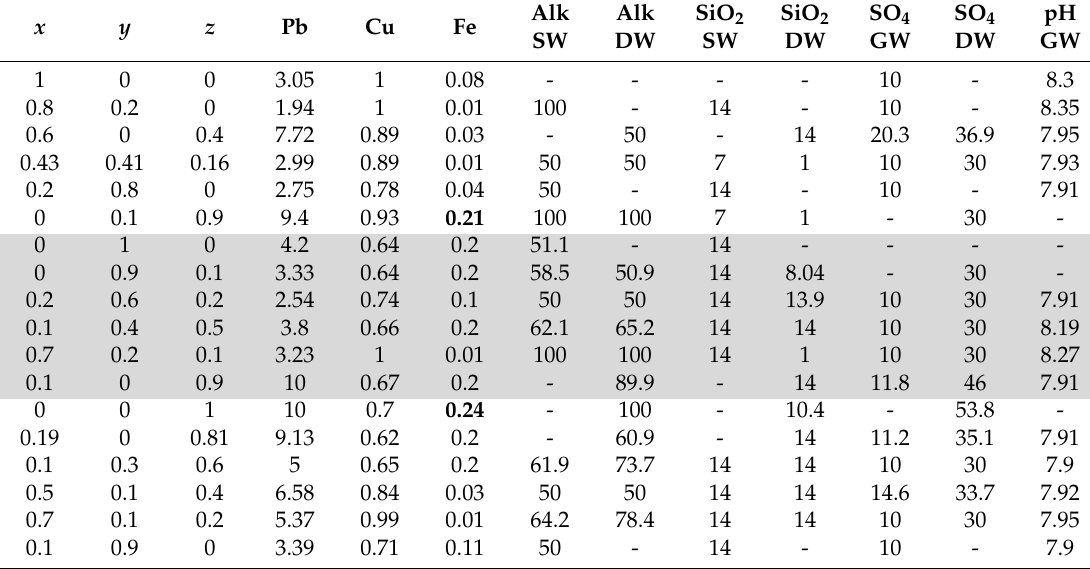
Table 5. Results of MSWBO with w 1 = 100, w 2 = 100 and w 3 =